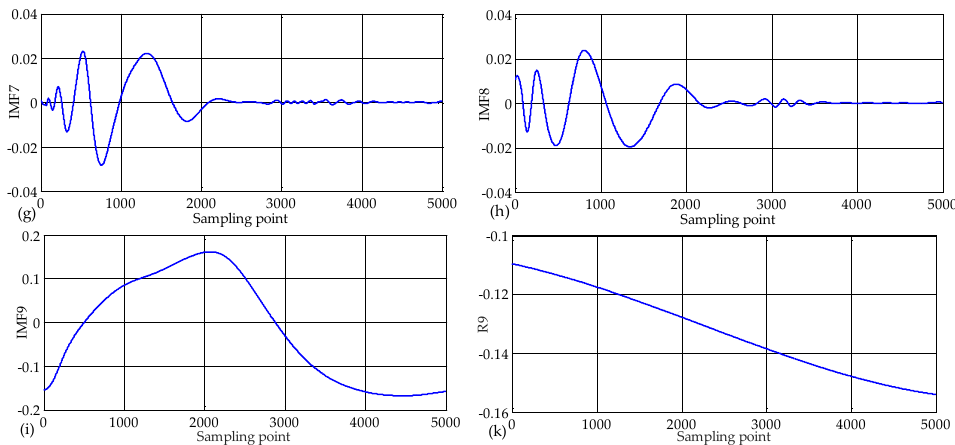
Figure 10. Empirical mode decomposition (EMD) results of the analytical signal at the terminal N: ( a ), ( b ), ( c ), ( d ), ( e ), ( f ), ( g ), ( h ), and ( i ) intrinsic mode function 1, 2, 3, 4, 5, 6, 7, 8, and 9 respectively; ( k ) the trend item of change of intrinsic mode function 9.